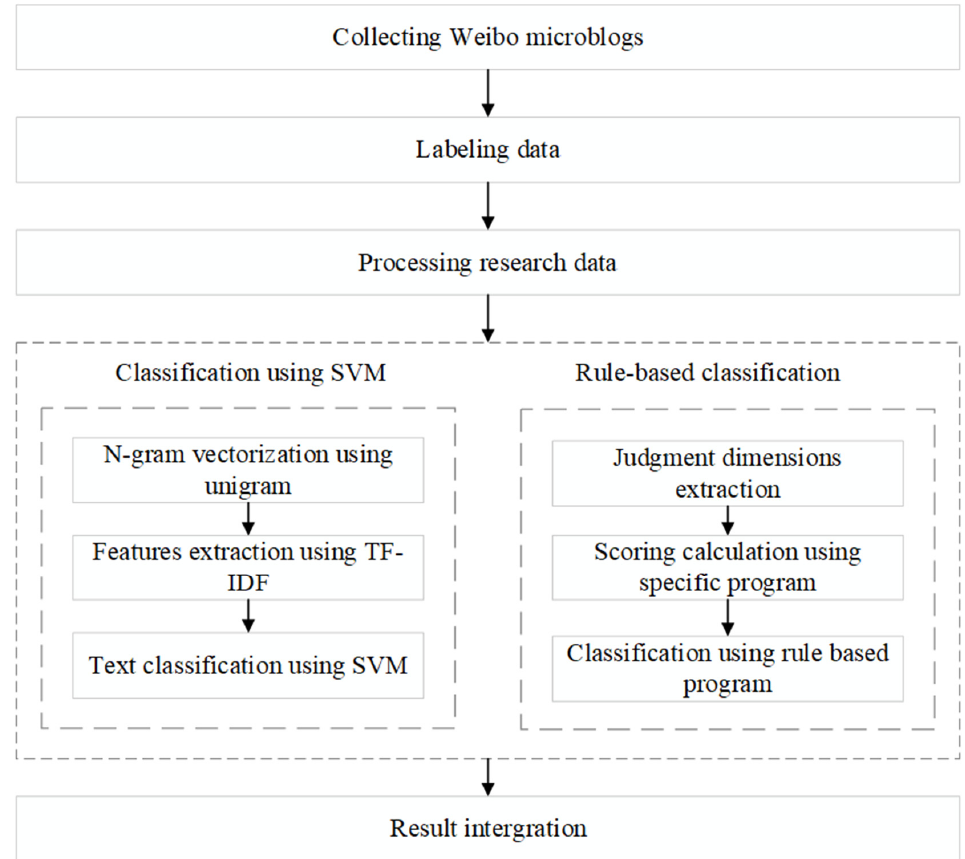
Figure 1. The integration process of MRIM.